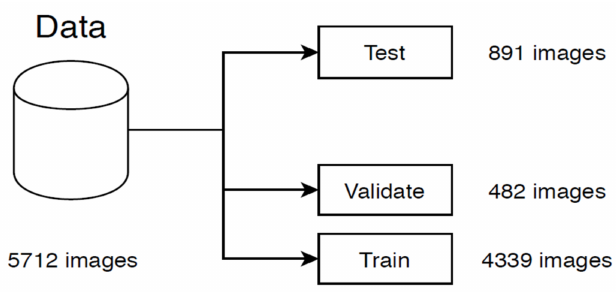
Figure 4. Overview of the test, train, and validation